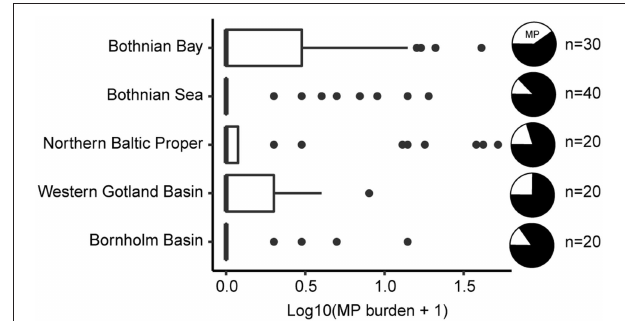
FIGURE 2 | Boxplot of Log 10 -transformed MP abundance in the gastrointestinal tract (GIT) of herring per basin; the basins are ordered from north to south. Data are presented as medians (vertical lines), inter quartile range, IQR (boxes), 1.5 IQR (whiskers) and outliers (points) deviating > 1.5 IQR. The black slices of the pie charts indicate the proportion of the fish with no MP in the GIT. Corresponding, untransformed data is provided in Table 2 .